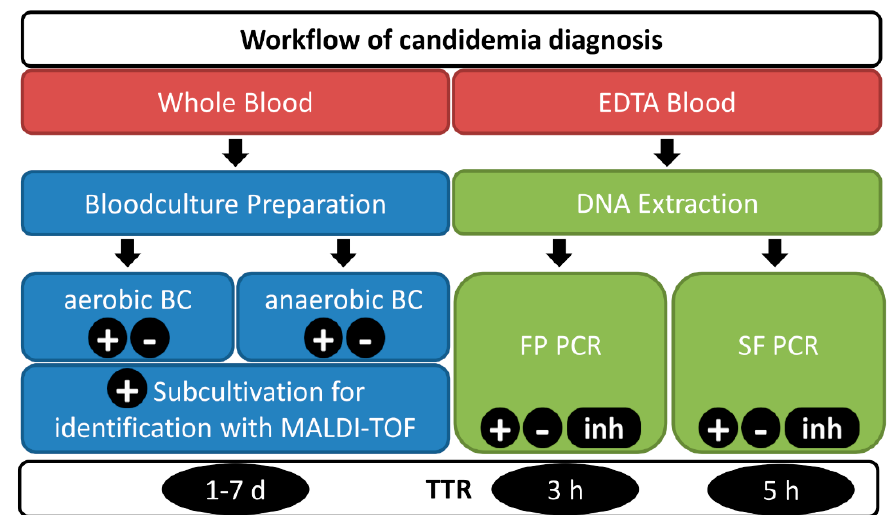
Figure 1. Diagnostic workflow including identification of Candida spp. in blood. Blood samples are sent for both blood culture and PCR-based diagnostics - Fungiplex (FP) and SeptiFast (SF). Ten milliliters of whole blood are injected into aerobic and anaerobic blood culture bottles. The SF test and FP PCR are run using the same DNA extract from 1 m L of EDTA blood. Positive blood cultures are subcultivated and analyzed using a MALDI-TOF system for species identification (ID). Results are reported as positive ( + ) including the identified species, negative (-) or, if PCR controls failed, as inhibited (inh). The time-to-result (TTR) varies between 1–7 days for BC (including ID) and 3–5 hours for the molecular tests.